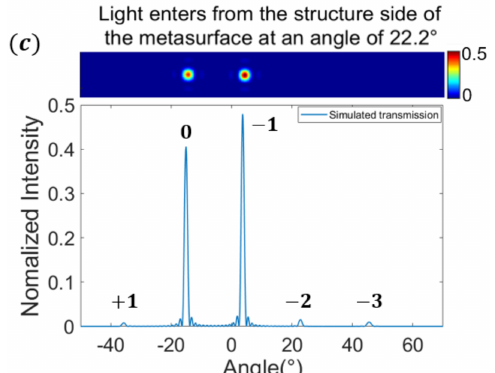
Figure 8. The far-field intensity for the three incident conditions with ( a ) − 3.7 ◦ incident angle. ( b ) 15 ◦ incident angle. ( c ) 22.2 ◦ incident angle. The far-field intensity is normal- ized to the total intensity of the input light. ( a ) and ( b ) represent the beam combining, ( c ) represents the beam